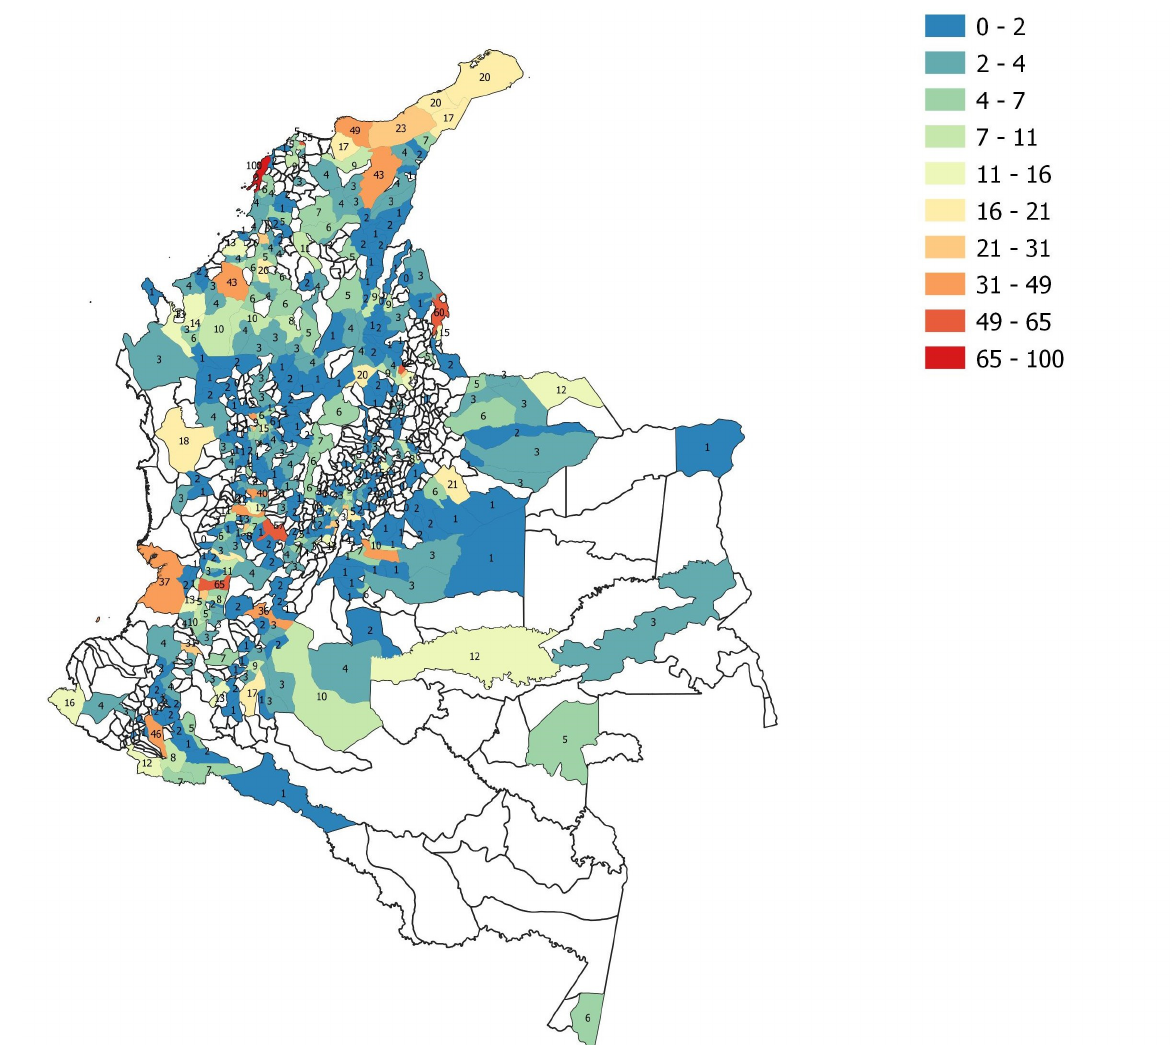
Figure 2. Example of range of movement map obtained according to the methodology described for 4 May 2021, with the exposure indicator in each administrative